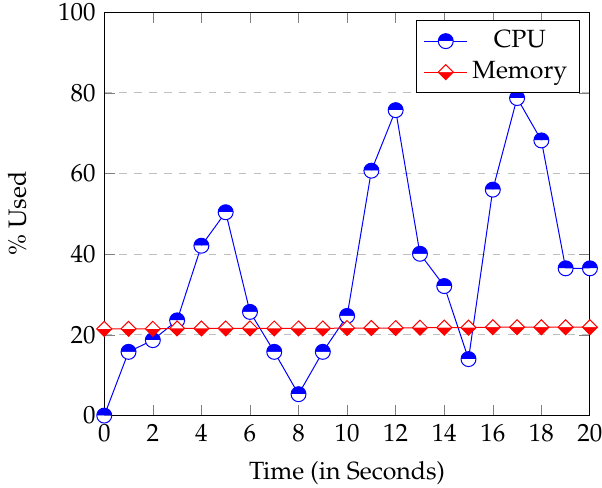
Figure 9. CPU and Memory Usage when the client is executed in the Raspberry